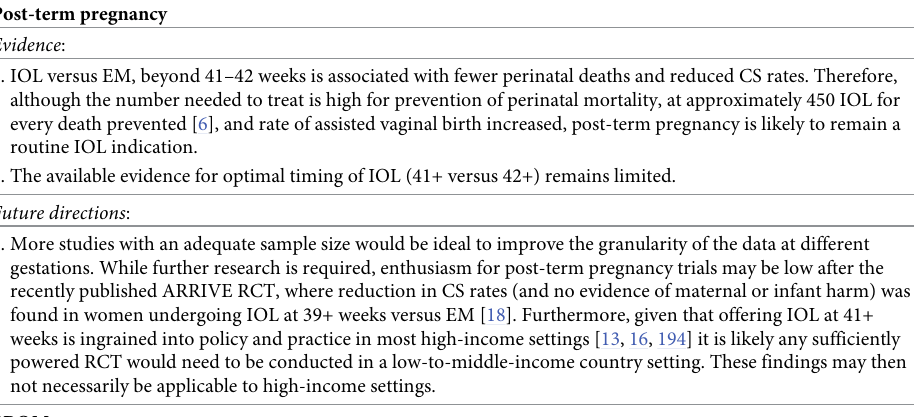
Table 3. Evidence summary and recommendations for future